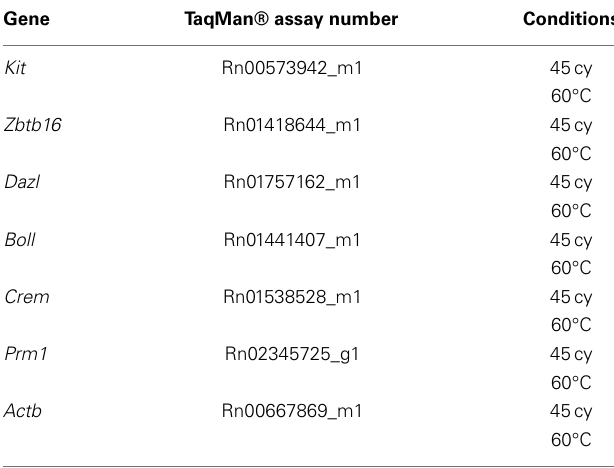
Table 3 |The assay and conditions used for